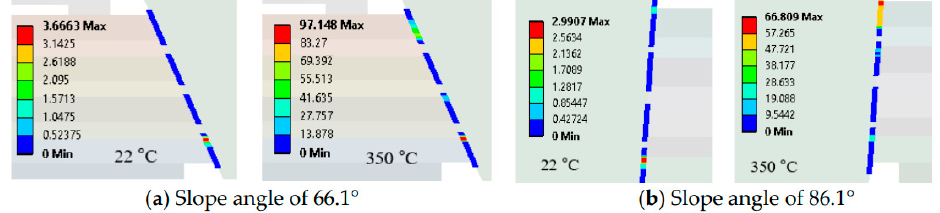
Figure 24. The 2D simulation results carried out by the previous study [18].